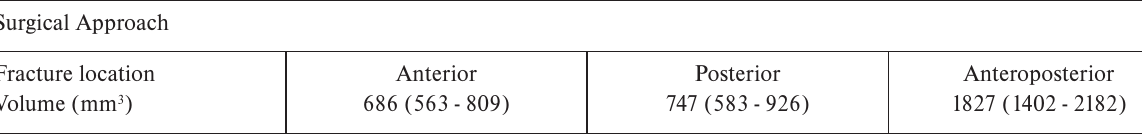
Table 3. Prolapsed volumes in blow-out fractures/surgical therapy.